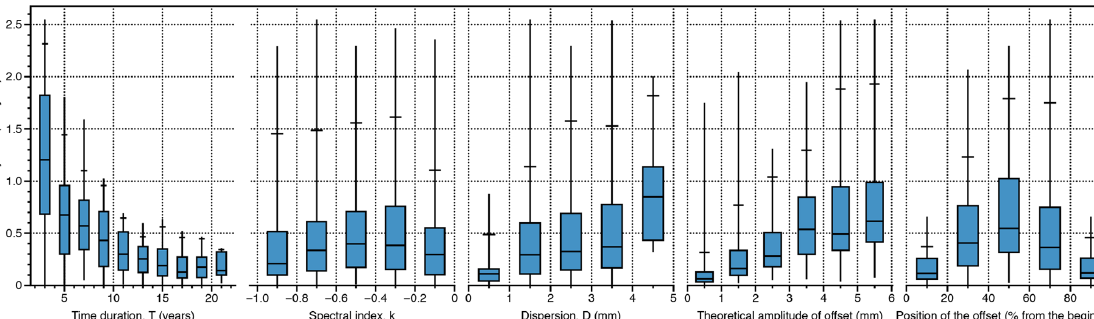
(cf. Fig. 4), with v 95 systematically above ca. 0.3 mm yr − 1